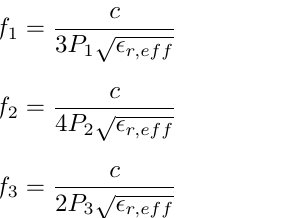
Figure 4: Average current distributions of the proposed an- tenna at 2.43, 3.5 and 5.765 GHz tween the branches contributing to the radiation. The ex- pression of the resonant frequency f 3 is given by equation 3